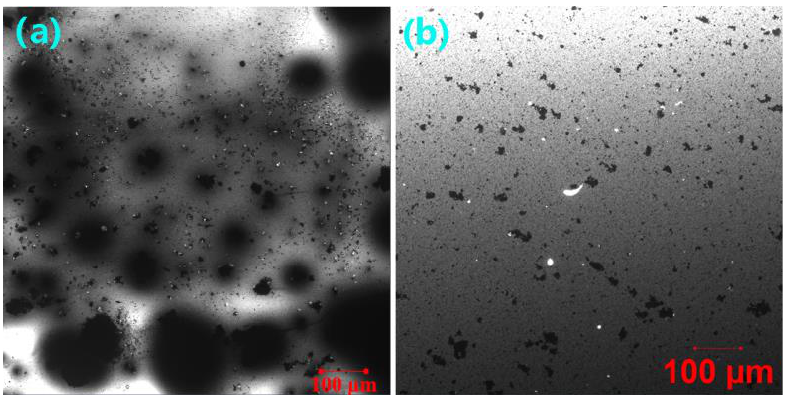
Figure 10. Transmission laser confocal microscopy images of ( a ) the unmodified asphalt rubber binder and ( b ) the modified asphalt rubber binder with 12% WCO.